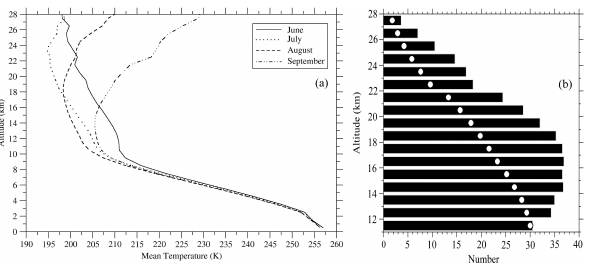
Fig. 8. (a) Monthly mean temperature profiles, for June to Septem- ber, for the 1979–2008 period and (b) occurrence of T <T NAT events according to the altitude for the June to September period, between 1989 and 2008; white circles indicate the number of sound-